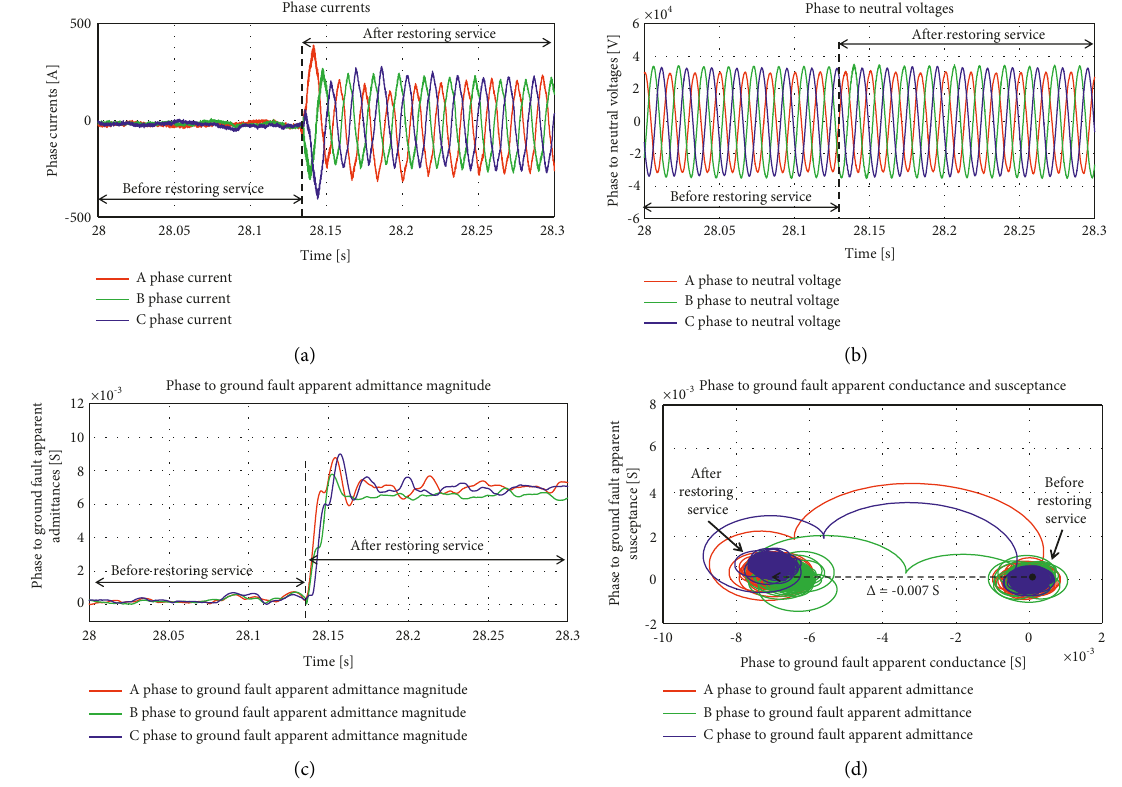
Figure 10: SIGID-931 event (a) currents, (b) voltages, (c) PGFA admittance magnitudes, and (d) PGFA conductance/susceptance from the optical power line sensors deployed on the (Figure 13(a)) and at the end of the power line section 38 (Figure 13(c)) were detected as nongrounding faults because the faulted phases were between 0.435 siemens (| Y |) and T 0.754 siemens (| Y |). However, the dynamic responses of T0